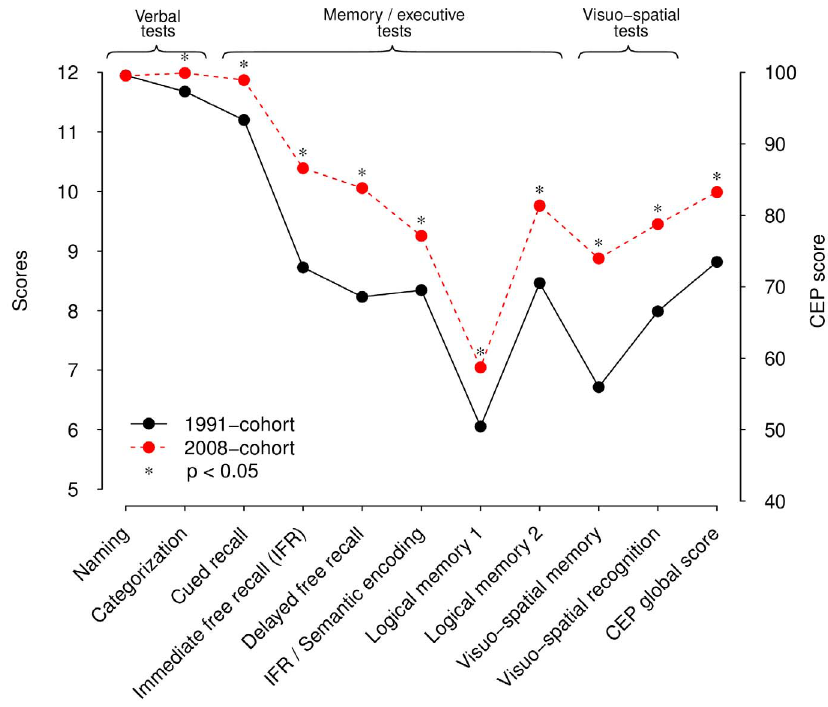
Figure 1. CEP global score and sub-scores of 1991- and 2008-samples.